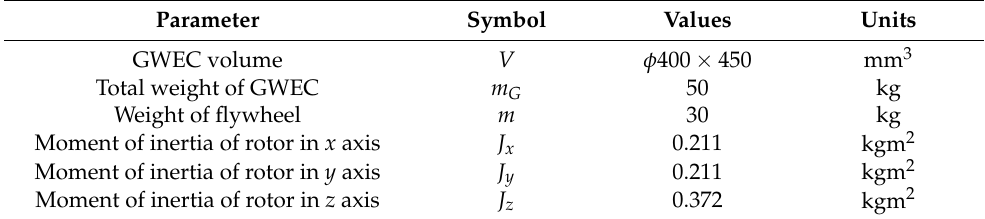
Table 1. GWEC parameters. Parameter